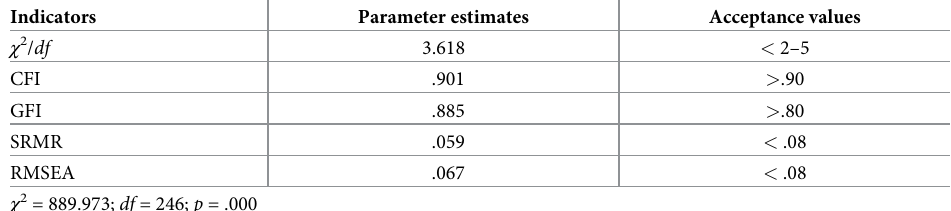
Table 2. Confirmatory factor analysis results for a three-factor model of 25 general science communication goals ( N =